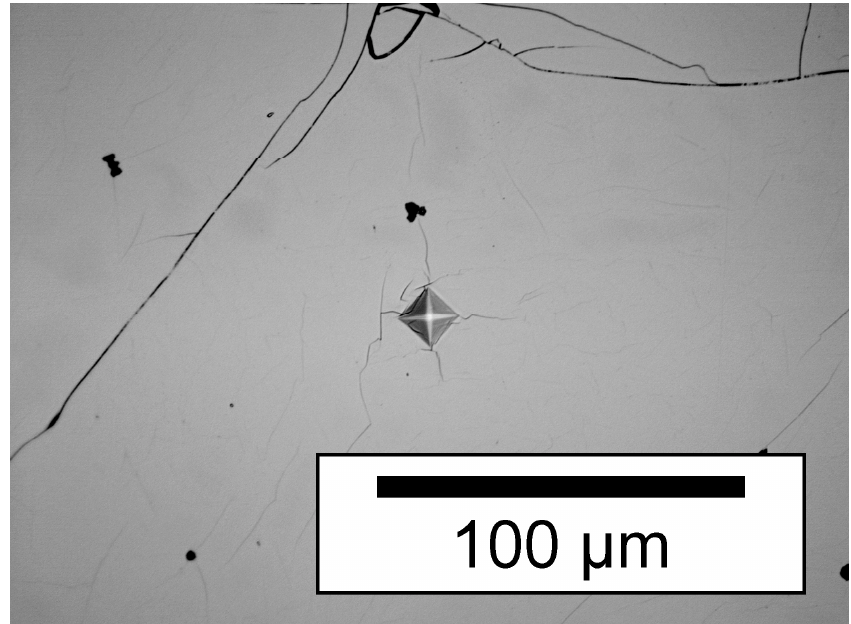
Figure 5. Indentation in a polished sample of ε -Fe 2 MnN for the determination of Vickers microhardness (optical micrograph, bright field contrast).